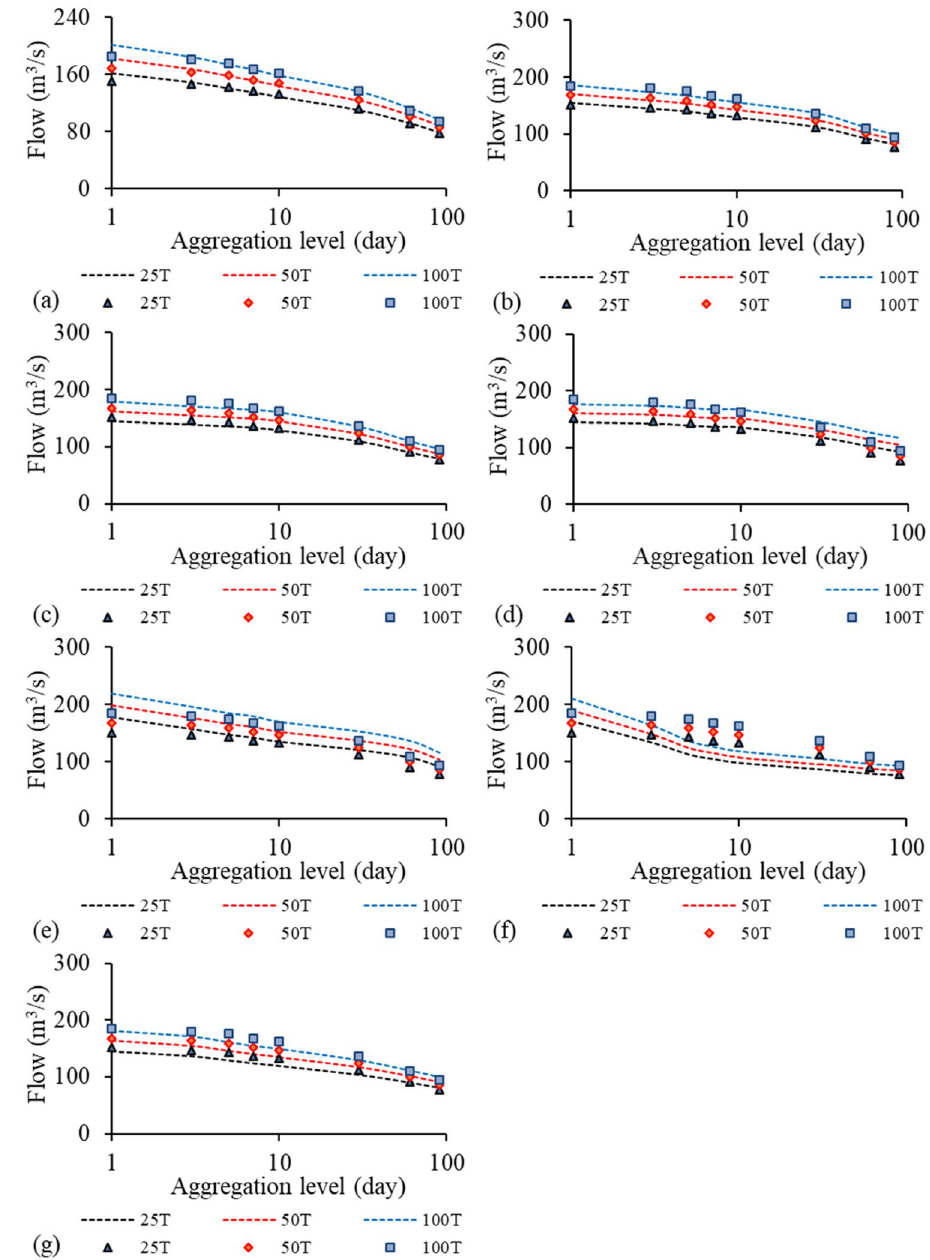
Fig. 12 The FDF plots for high extreme observed and simulated flows obtained at different aggregation levels (1–90 days) for a AWBM, b SAC, c TANK, d IHACRES, e SIMHYD, f SMAR, g HMSV obtained at 25-, 50- and 100-year return periods. In the legend, dashed lines denote simulated flow, while the markers signify observed